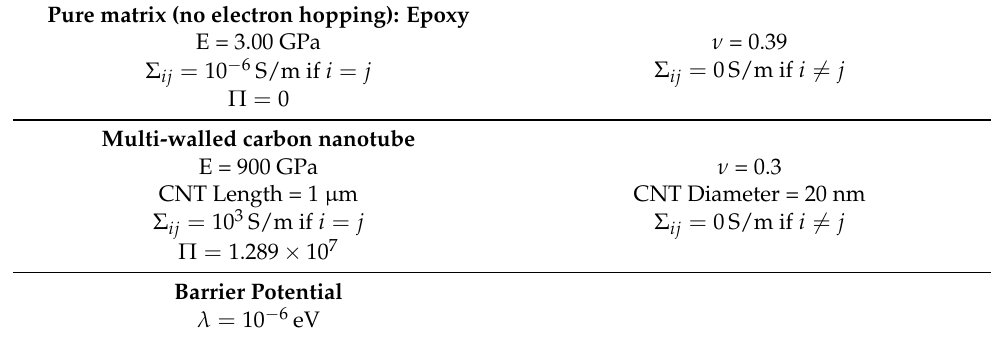
Table 1. CNT and polymer isotropic homogeneous material properties (E: Young’s modulus, ν : Poisson’s ratio, Σ ij : components of electrical conductivity, Π : nanoscale effective piezoresistivity coefficient). Pure matrix (no electron hopping):